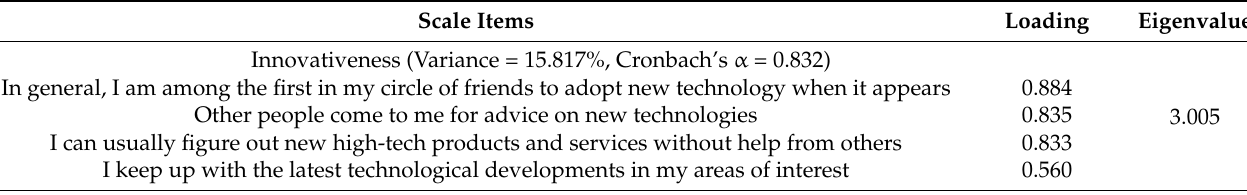
Table 2. Results of the reliability and validity